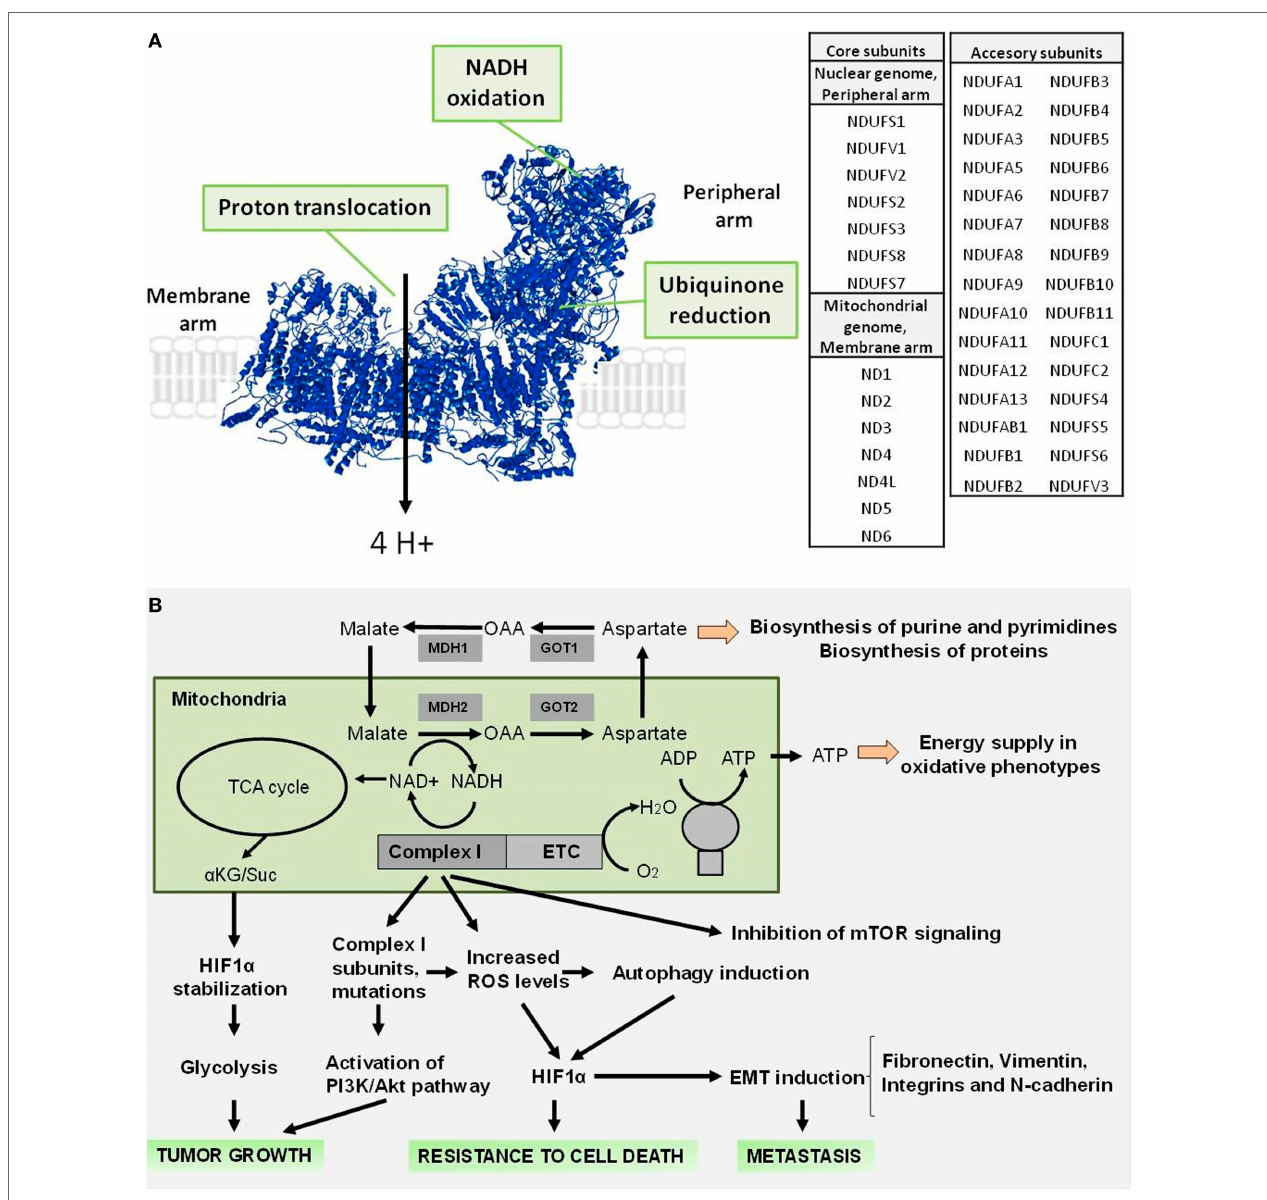
FigURe 1 | Structure of mammalian respiratory Complex I and role during tumorigenesis. (A) Structure of mammalian Complex I (PDB: 4UQ8), indicating the sites involved in the NADH oxidoreductase activity (NADH oxidation and ubiquinone reduction) in the peripheral arm and in the proton translocation in the membrane arm. A list of the core and accessory subunits that compose the mitochondrial Complex I is shown. (B) Complex I signaling involved in the supporting of tumor growth, resistance to cell death, and promoting of metastasis.